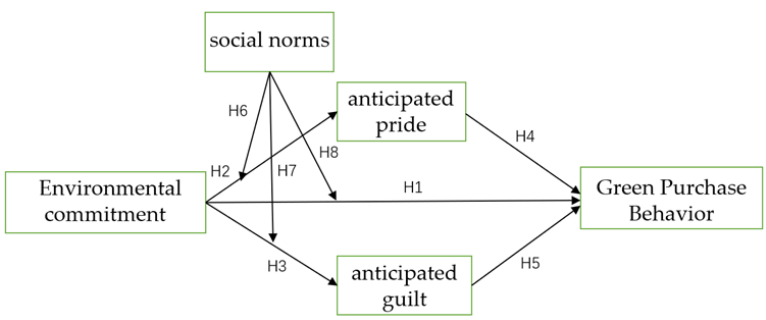
Figure 1. Research framework